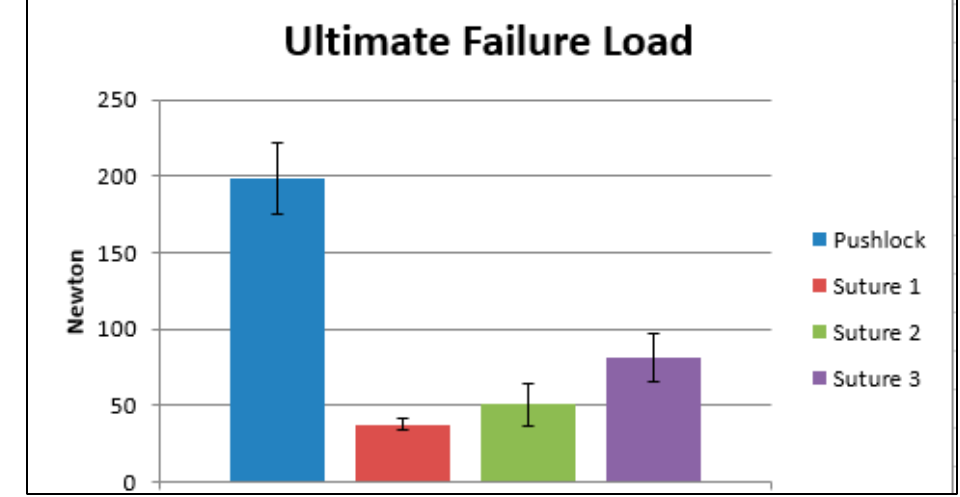
Figure 6. Ultimate Failure